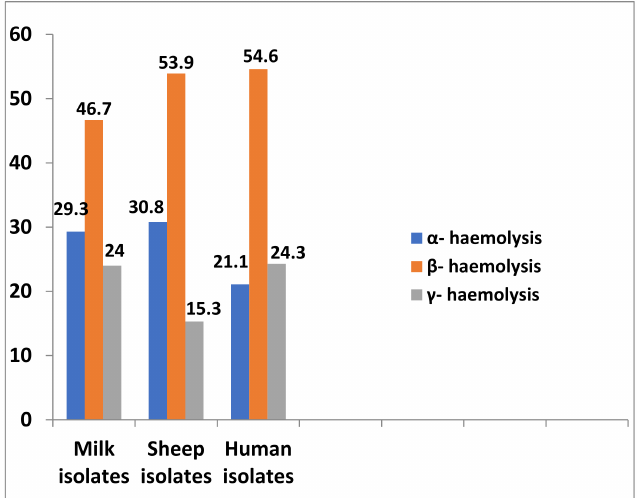
Figure 3. Types of haemolysis produced by Staphylococcus spp. isolated from different sources. For biofilm formation, a total of 72 isolates (46.8%) were phenotypically biofilm producer on Congo red agar (CRA) medium, among which 52 isolates (33.8%) were produced as strong and 20 isolates (13%) as intermediate. In contrast, 82 isolates (53.2%) not produced biofilm. Biofilm production represented 49.3, 38.5 and 45.5% in the milk, sheep and human isolates, respectively (Table S1 and Figure 4).